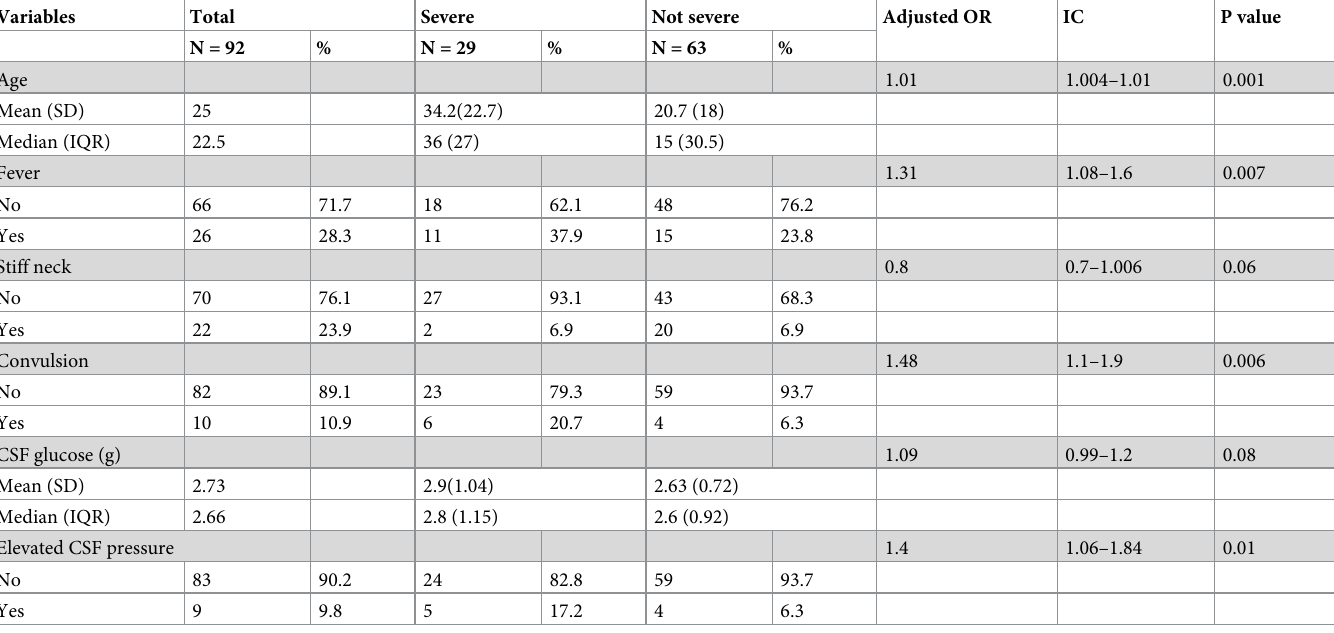
Table 7. Final model of New Caledonian cases of EM according to severity, n =